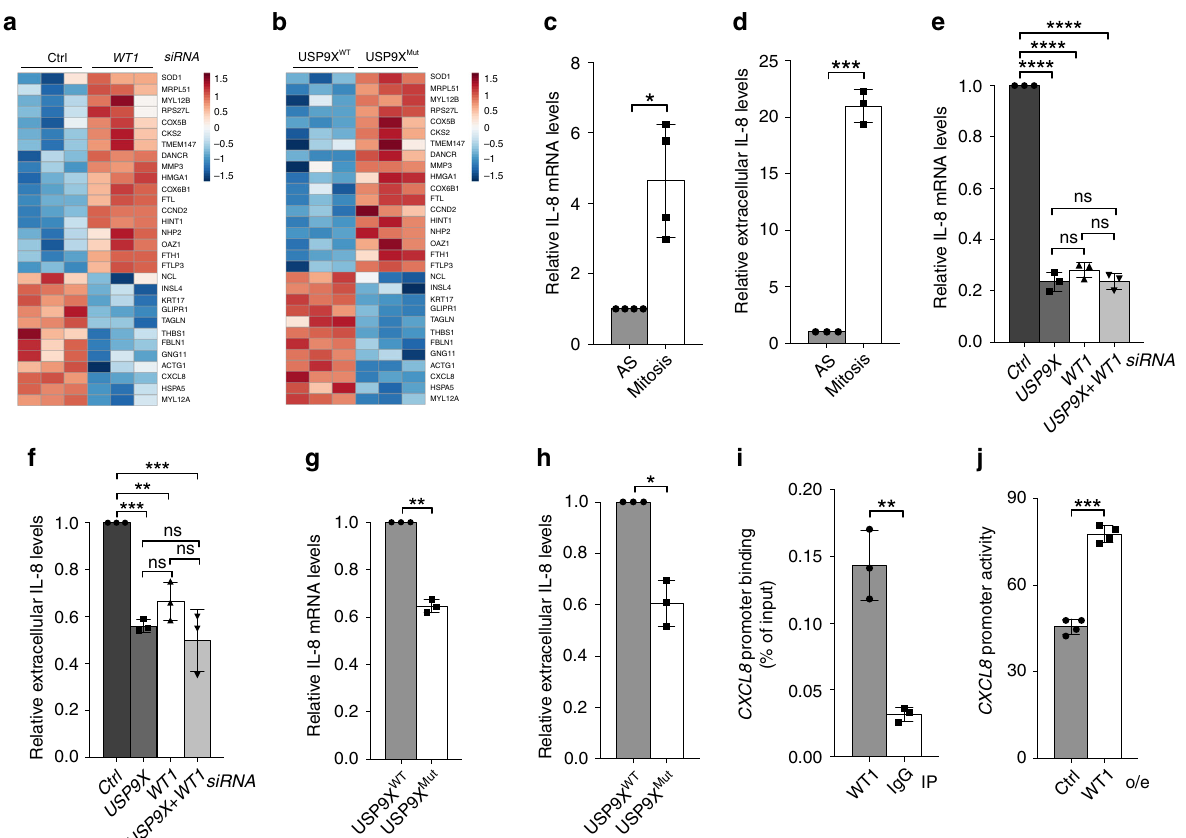
Fig. 3 WT1 regulates IL-8 transcription and secretion in mitosis. a Heatmap of RNA-Seq analysis depicting differentially regulated genes in mitotic control cells versus WT1 knockdown U2OS cells. Each column displays an independent biological replicate, negatively regulated genes on the top, positively regulated genes on the bottom. b RNA-Seq analysis showing differentially regulated genes in mitotic USP9X WT versus USP9X Mut U2OS cells. c Quantitative RT-PCR showing accumulation of IL-8 mRNA in mitotically synchronized versus asynchronous U2OS cells. Mean is shown from n = 4 biologically independent experiments. One sample t -test was applied with * p = 0.0198. d Extracellular IL-8 measured by ELISA is increased in the supernatant of mitotic versus asynchronous U2OS cells. Mean is shown from n = 3 biologically independent experiments. Ratio paired t -test was applied with *** p = 0.0002. e Quantitative RT-PCR from mitotic U2OS cells showing reduced IL-8 mRNA levels in response to USP9X , WT1 , or double compared to control knockdown. Mean is shown from n = 3 biologically independent experiments. One-way ANOVA was applied with **** p <0.0001 followed by Dunnett ’ s test with **** p < 0.0001 ( p ( USP9X versus WT1 ) = 0.211; p ( USP9X versus USP9X + WT1 ) > 0.9999; p ( WT1 versus USP9X + WT1 ) = 0.2061). f Secreted IL-8 measured by ELISA in the supernatant of mitotic U2OS cells following USP9X , WT1 , or double versus control knockdown. Mean is shown from n = 3 biologically independent experiments. One-way ANOVA was applied with *** p = 0.0001 followed by Dunnett ’ s test with *** p (Ctrl versus USP9X ) = 0.0004, ** p (Ctrl versus WT1 ) = 0.0055, *** p (Ctrl versus USP9X + WT1 ) = 0.0002; p ( WT1 versus USP9X ) = 0.3081, p ( WT1 versus USP9X + WT1 ) = 0.0791, p ( USP9X versus USP9X + WT1 ) = 0.6772. g Quantitative RT-PCR showing reduced IL-8 mRNA in USP9X Mut versus USP9X WT U2OS cells that were mitotically synchronized using nocodazole. Mean is shown from n = 3 biologically independent experiments. One sample t -test was applied with ** p = 0.002. h ELISA showing reduction of secreted IL-8 in the supernatant of mitotically synchronized USP9X Mut compared to USP9X WT U2OS cells. Mean is shown from n = 3 biologically independent experiments. Ratio paired t -test was applied with * p = 0.0277. i Chromatin immunoprecipitation (ChIP) showing WT1 occupancy on the CXCL8 promoter in nocodazole-synchronized U2OS cells. ChIP signal was quanti fi ed using RT-PCR. WT1 occupancy was normalized to total input DNA. Mean from n = 3 biologically independent experiments is shown. Ratio paired t -test was applied with ** p = 0.00277. j CXCL8 reporter assay performed in nocodazole-treated U2OS cells that were transfected with luciferase reporter construct harboring the human CXCL8 promoter or an empty reporter construct and a WT1 overexpressing vector as indicated. Luminescence was normalized to the background luminescence of the empty reporter construct. Mean is from n = 4 biologically independent experiments. Ratio paired t -test was applied with *** p = 0.0007. Throughout this fi gure standard deviations are displayed as error